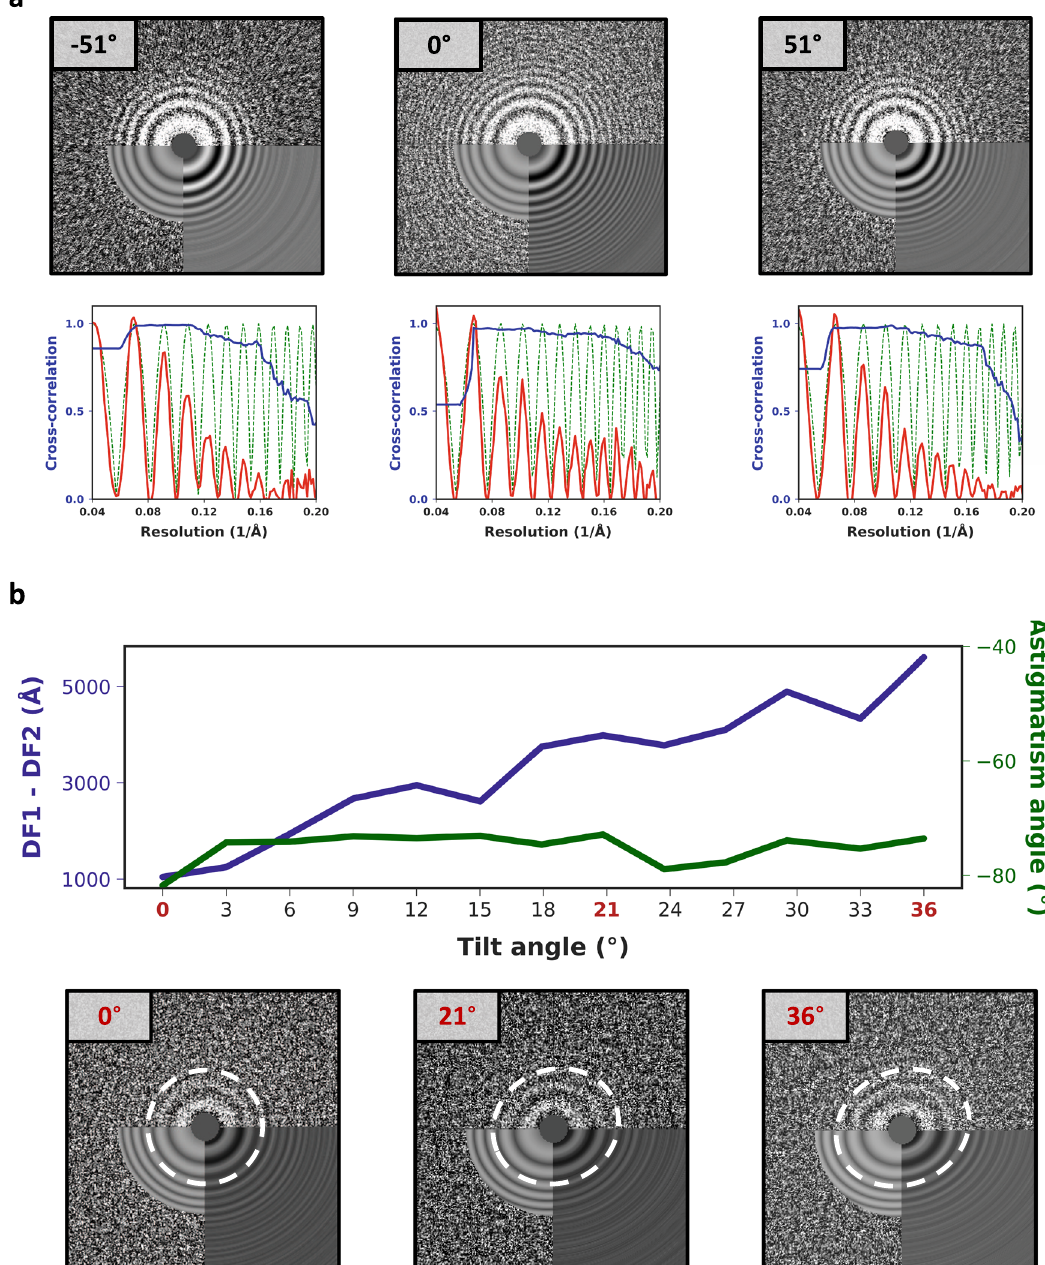
Fig. 3 Astigmatic tilted-CTF determination from low-dose tomographic tilt-series. a 2D power spectra from projections at − 51°, 0°, and 51° from a tilt- series downloaded from EMPIAR-10453 (top) and corresponding fi tted 1D models (bottom) showing radially averaged CTF pro fi le (red), estimated defocus (green dashed line), and CTF fi t scores (blue). b Astigmatic CTF estimation in the positive branch of a tilt-series from the dNTPase sample. Plots show variations in the astigmatism angle (green) and defocus differences (blue) across the tilt range (top). Corresponding 2D power spectra obtained from tilt angles 0, 21 and 36° showing changes in astigmatism (bottom). To facilitate the visualization, we choose to show a tilt-series with unusually high astigmatism variation. In general, no systematic variations in astigmatism were observed for data collected using BISECT or downloaded from the EMPIAR quality of our BISECT/CSPT structure against standard SPA reconstruction using images acquired from the same grid. We collected a single-particle dataset consisting of 2275 movies (using Fig. 8. This result validates the effectiveness of our combined the same 25 holes BIS scheme) and extracted a similar number of approach for high-speed data collection and high-resolution particles as in the CSPT reconstruction (~34k) from the best 64 CET/SVA data processing and represents the fi rst example of a micrographs, yielding a reconstruction at 3.3 Å resolution using near-atomic resolution structure of a low-molecular weight target standard protocols for SPA re fi nement 26 , Fig. 6a. The improve- ment in resolution is consistent with the higher quality of the SPA obtained from tomographic tilt-series. We also compared the